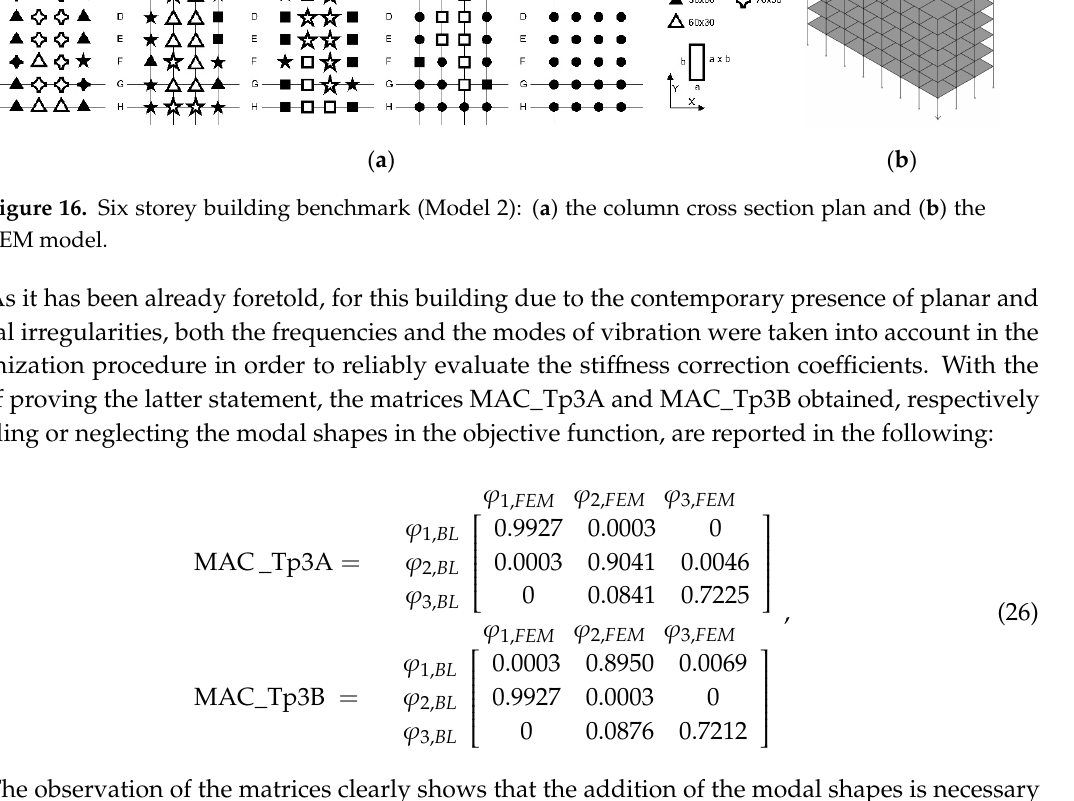
Table 4. Modal Period comparison.